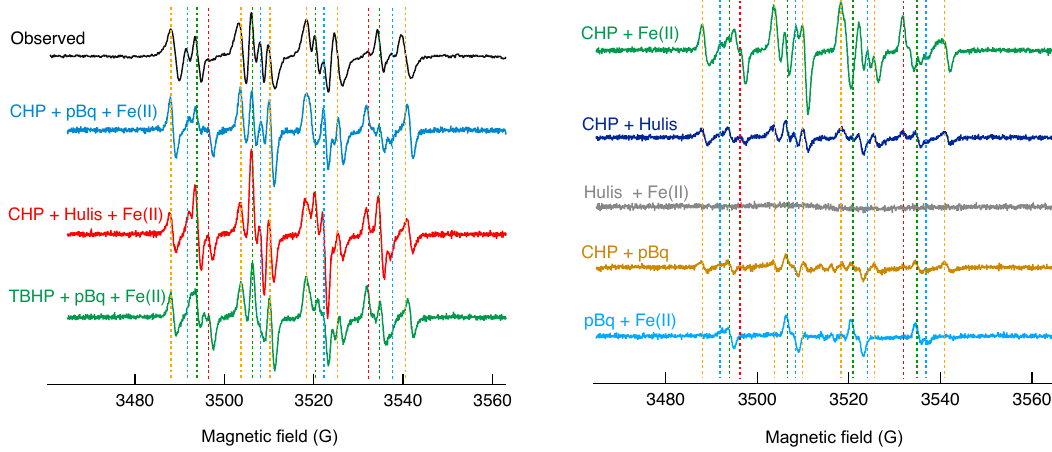
Figure 6. Electron paramagnetic resonance (EPR) spectra of atmospheric aerosol impactor sample with particle diameters in the range of 180–320nm (lower to upper cut-off) extracted with water and BMPO (black) and of aqueous substance mixtures with the following ingredients: cumene hydroperoxide (CHP), p-benzoquinone (pBq) and Fe(II) (light blue) and t-butyl hydroperoxide (TBHP). The dashed vertical lines indicate the main peaks of BMPO adducts with O − (red), OH (green), carbon- (light blown) and oxygen-centered organic 2 radicals (light